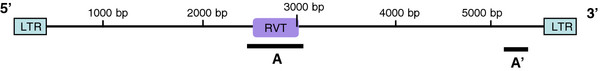
Fragments position in Corky element used in RT- qPCR. Real-time PCR was performed in two regions of Corky element: RVT (A) and the region between the integrase and the chromodomain (A’).